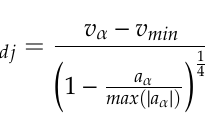
Table 2. Types and descriptions of driver parameters.